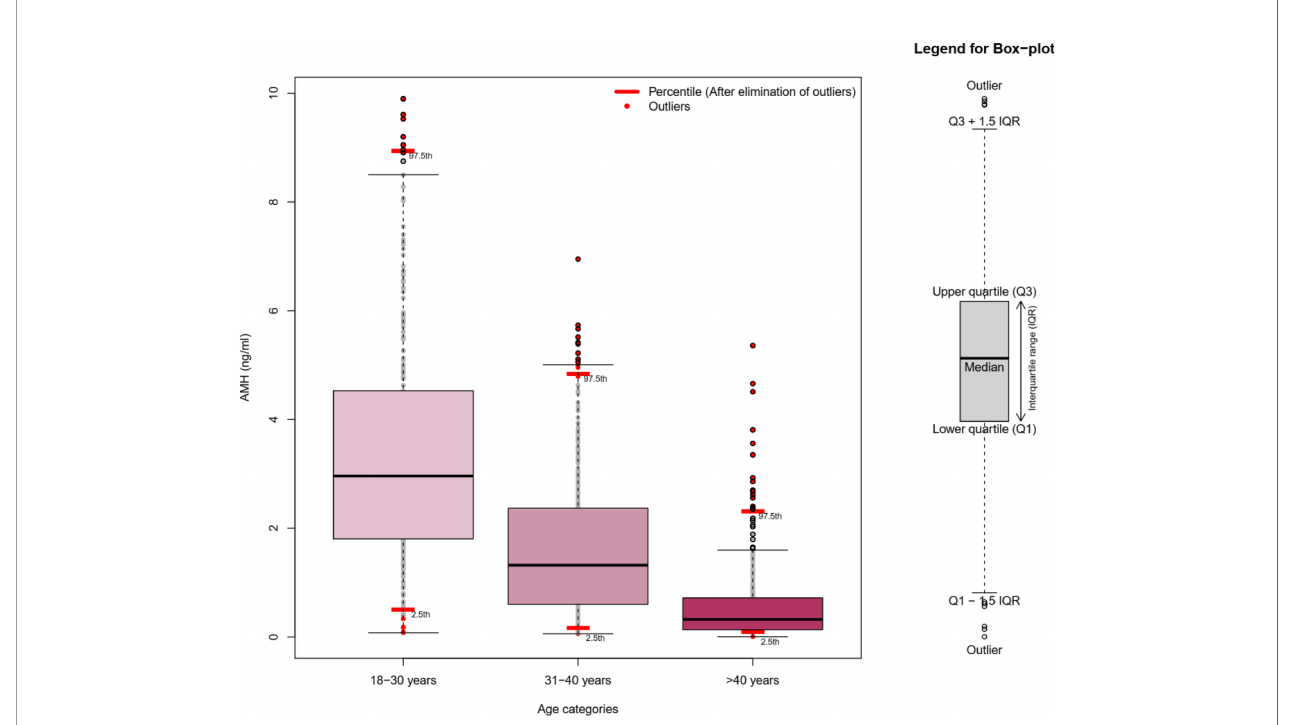
FIGURE 1 | Comparing trim data outlier detection with the box plot approach across age categories.